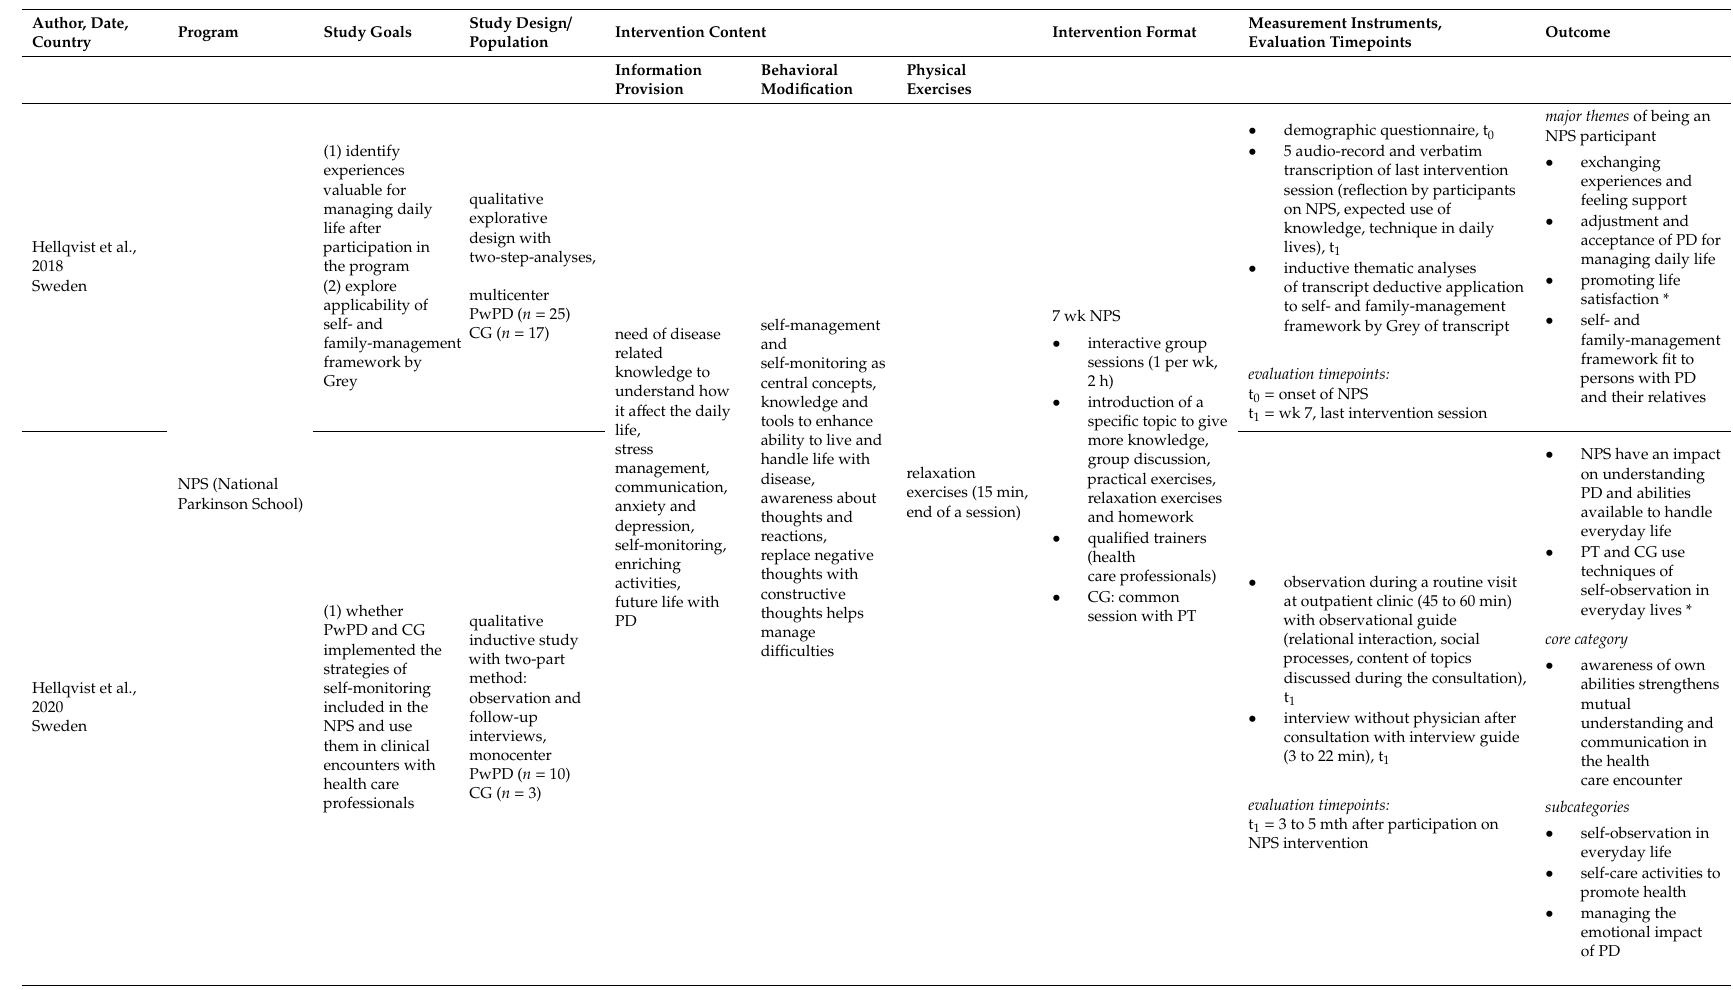
Table 2. Qualitative evaluation